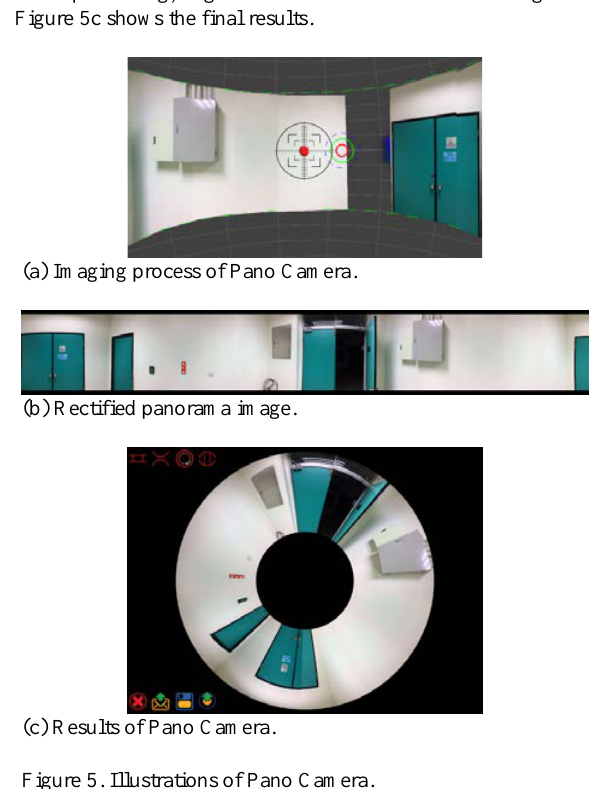
Figure 5. Illustrations of Pano